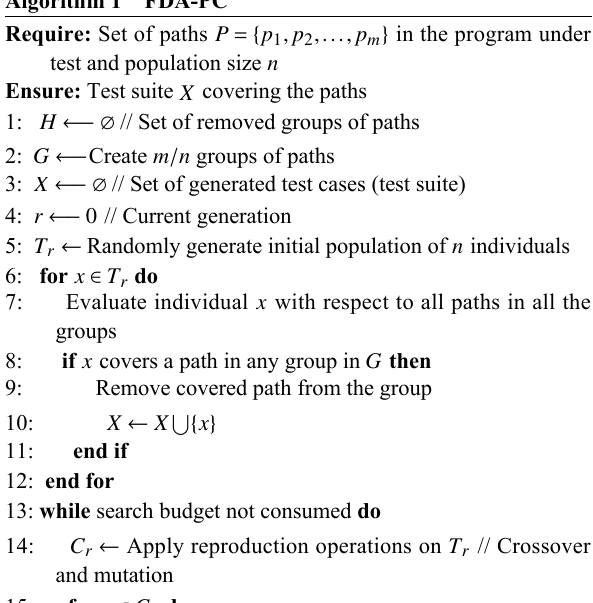
Algorithm 1 FDA-PC